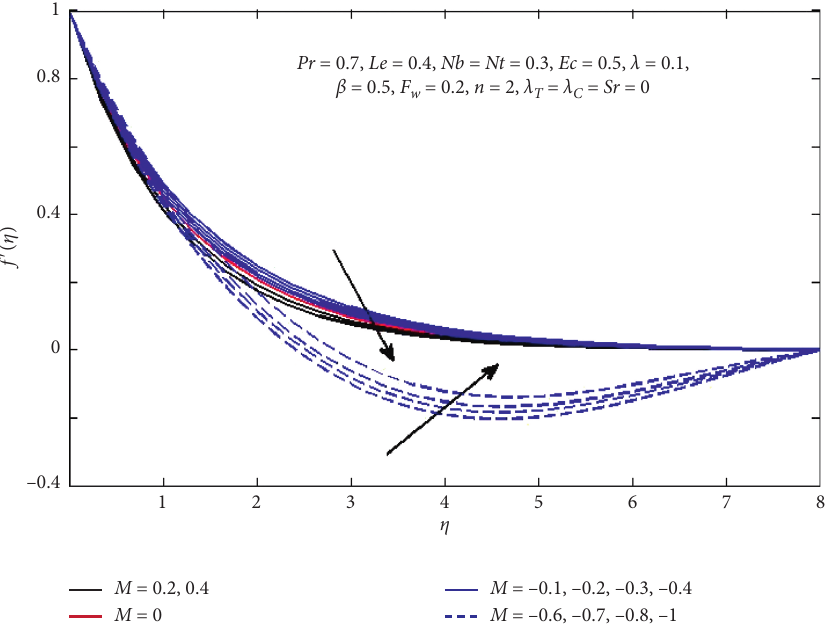
Figure 14: Variation of velocity f ′ concerning η with various values of M